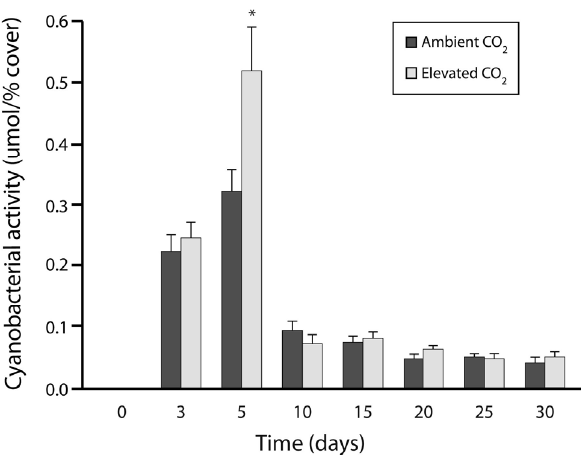
Figure 4. Cyanobacterial activity of N. punctiforme as measured by the ethylene (C 2 H 4 ) produced per percentage cover of cultures. Samples were grown on 27 mm diameter agar vials over 30 days under ambient (430 ppm) and elevated (750 ppm) atmospheric CO 2 conditions. All data are plotted as mean ± SD; pairwise differences are shown using an asterisk symbol (*).